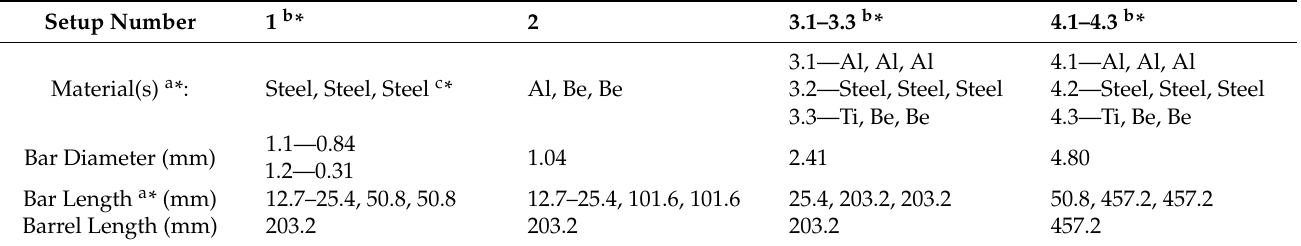
Table 2. Table of bar specifications for each